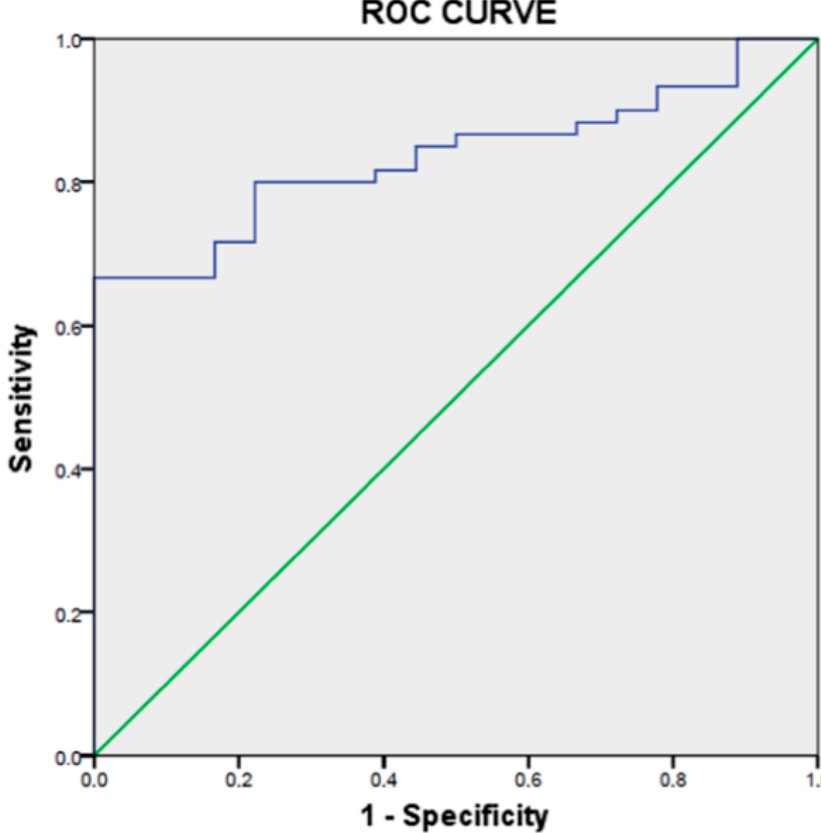
Figure 3. ROC curve representing the different cuts-off of ECV.